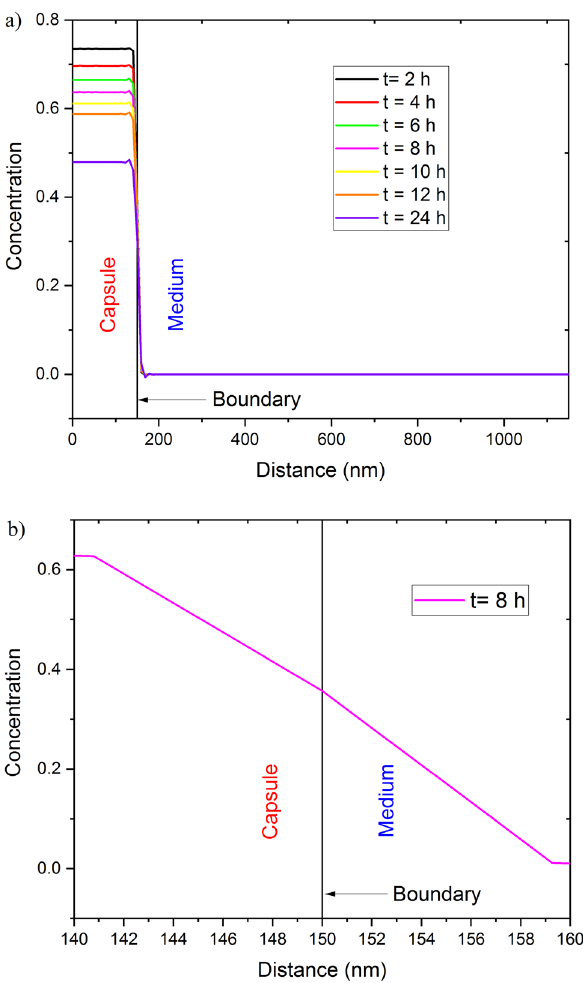
Figure 6. Drug concentration profiles at h = 0.3: ( a ) through the whole geometry of simulation ( b ) around the